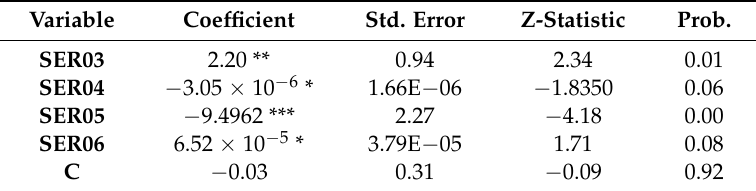
Table 8. Results of Tobit regression analysis of influencing factors